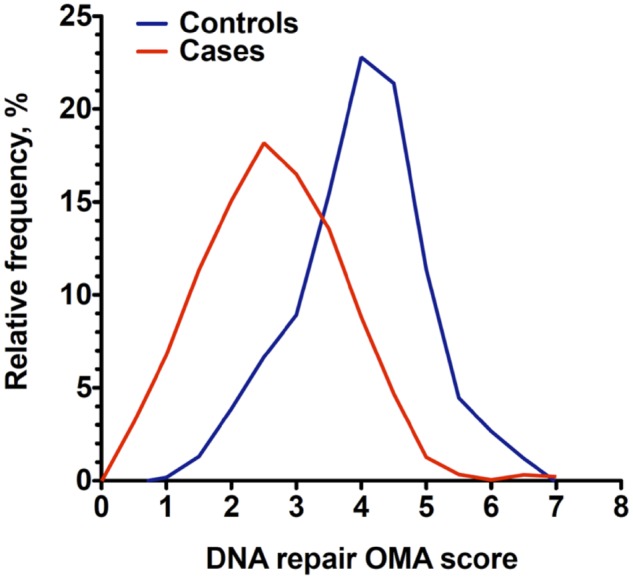
DNA Repair score distribution among lung cancer case patients and control individuals. The frequency distribution of DNA Repair scores is shown for 149 lung cancer patients (red curve) and 140 control individuals (blue curve). The graphs were plotted using GraphPad Prism version 5.00 (GraphPad Software, San Diego, CA), with bin width automatically chosen by the software, with second- order smoothing, with two neighbors on each size. Bin width was 0.5 units. APE1 = apurinic/apyrimidinic endonuclease 1; MPG = methylpurine DNA glycosylase; OGG1 = 8-oxoguanine DNA glycosylase; OMA = OGG1, MPG, and APE1.